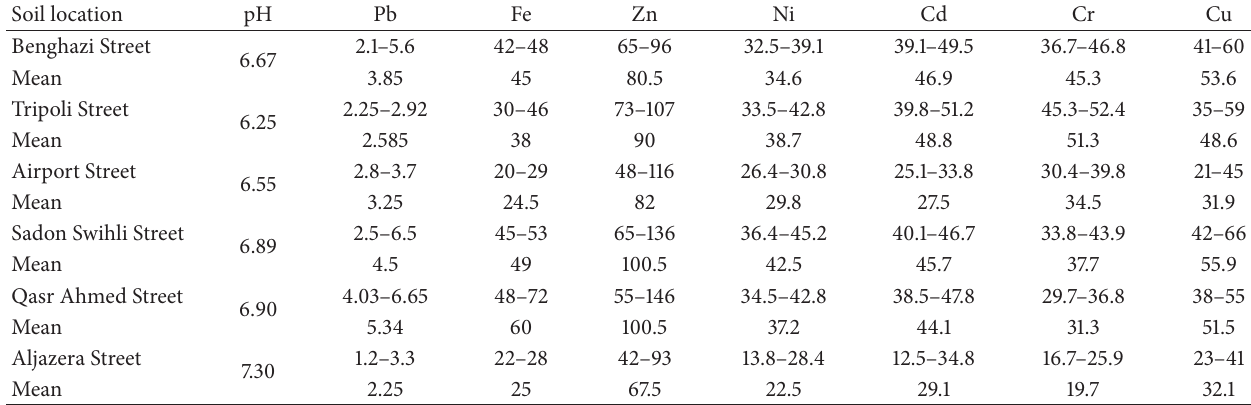
Table 1: Heavy metal concentration 𝜇 g g − 1 and pH in roadside